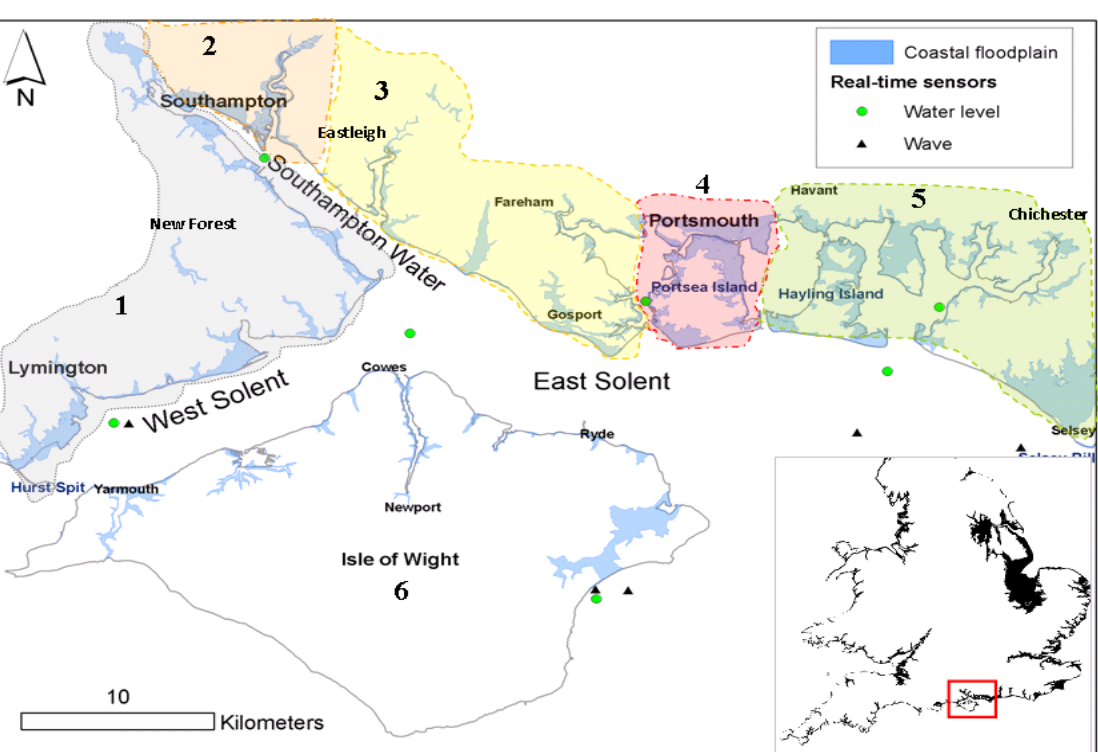
Figure 1. The Solent case-study, locations of wave and water level recorders, and the approximate 1 in 1000 year coastal floodplain (refer to Section 3.2). The base map (lower right) is an Environment Agency 1 in 1000 year indicative coastal floodplain for England and Wales [31]. Sub-regions used to describe flood modelling results later in the paper are: ( 1 ). The New Forest; ( 2 ). The city of Southampton; ( 3 ). The boroughs of Eastleigh, Fareham and Gosport; ( 4 ). The city of Portsmouth; ( 5 ). The boroughs of Havant and Chichester; ( 6 ). The Isle of